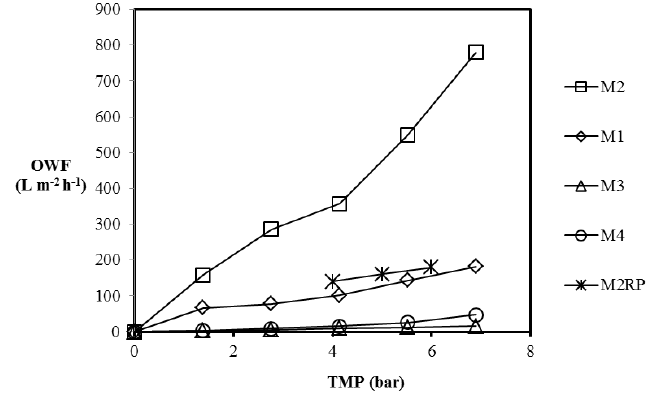
Figure 8. Oil–water flux (OWF) of the membranes. Experimental conditions: temperature: room temperature, membrane area: 42 cm 2 ; TMP: 1.38–6.90 bar.